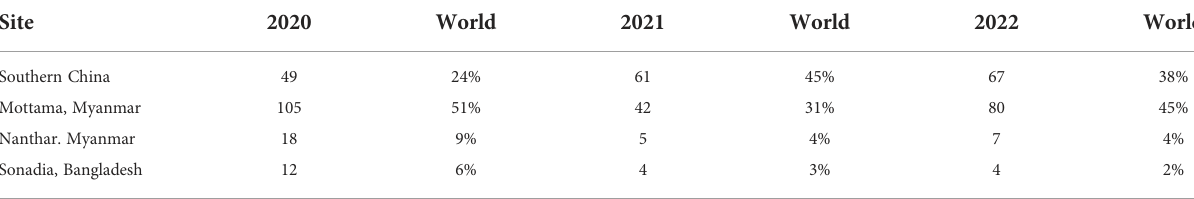
TABLE 1 The wintering population and the proportion to the global population of Spoon-billed Sandpipers in the top four important wintering areas in the world*.